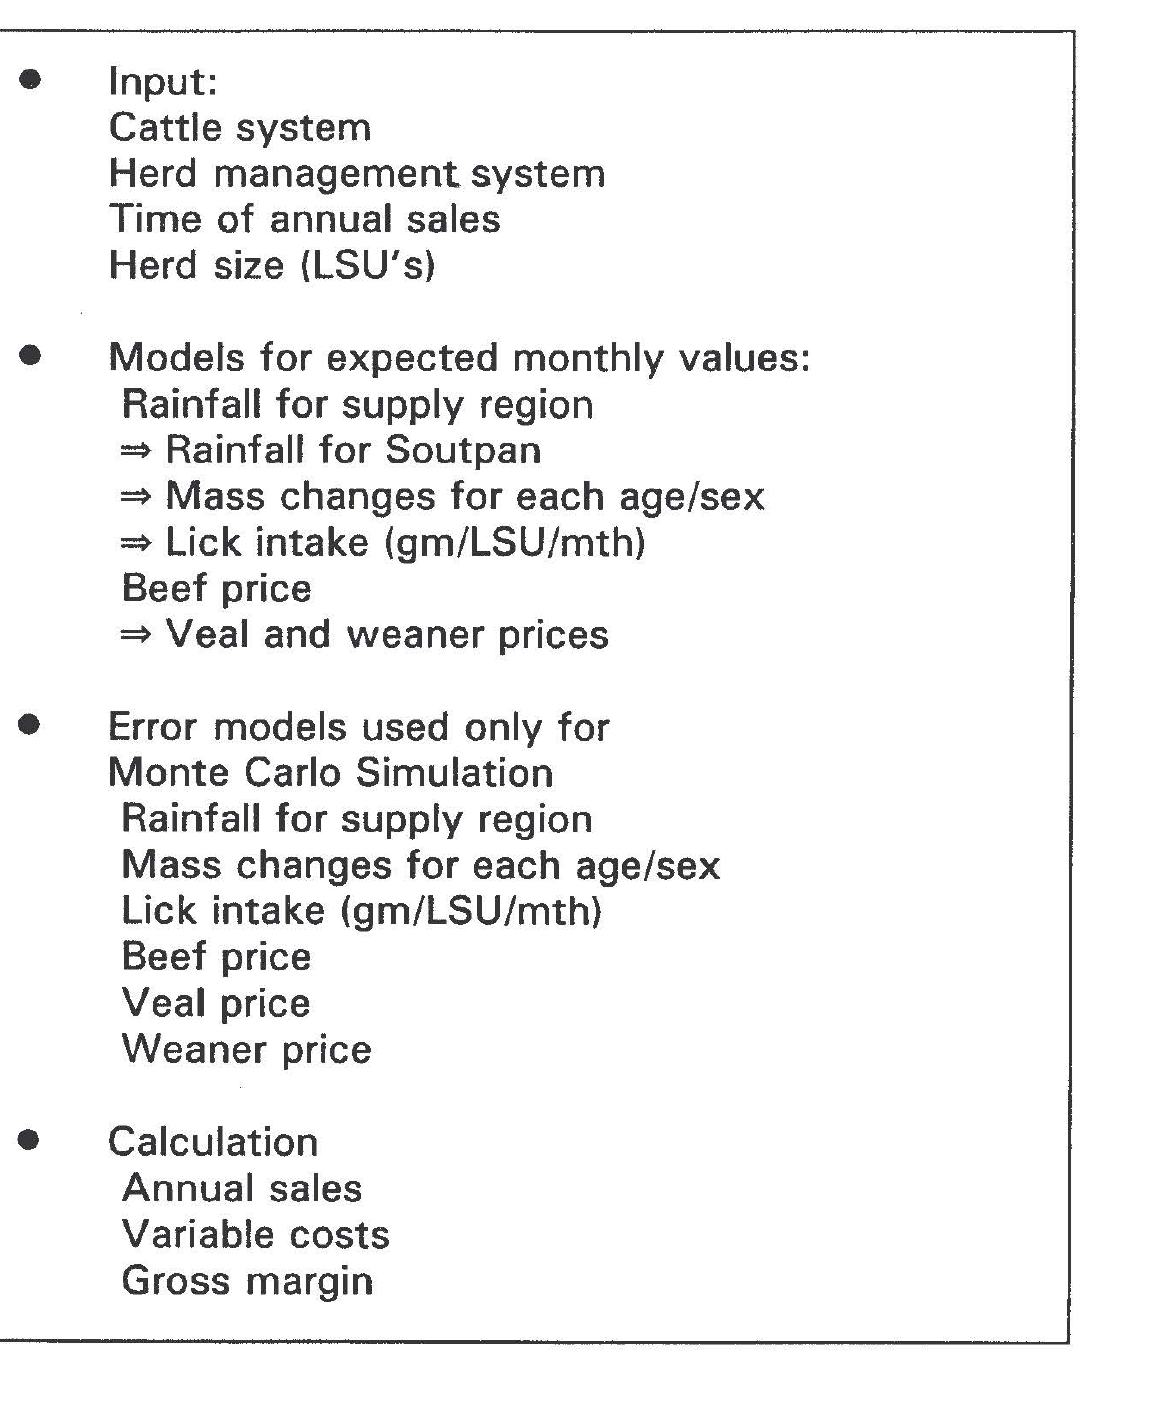
Figure 7: Monthly generation of data for DSS